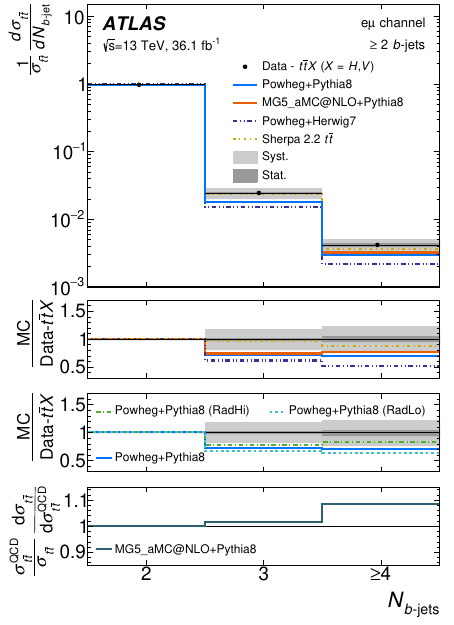
Figure 8. The relative di(cid:11)erential cross-section as a function of the b -jet multiplicity in events with at least two b -jets in the e(cid:22) channel compared with various MC generators. The t (cid:22) tH and t (cid:22) tV contributions are subtracted from data. Three ratio panels are shown, the (cid:12)rst two of which show the ratios of various predictions to data. The third panel shows the ratio of predictions of normalised di(cid:11)erential cross-sections from MadGraph5 aMC@NLO+ Pythia 8 including (numerator) and not including (denominator) the contributions from t (cid:22) tV and t (cid:22) tH production. Uncertainty bands represent the statistical and total systematic uncertainties as described in section